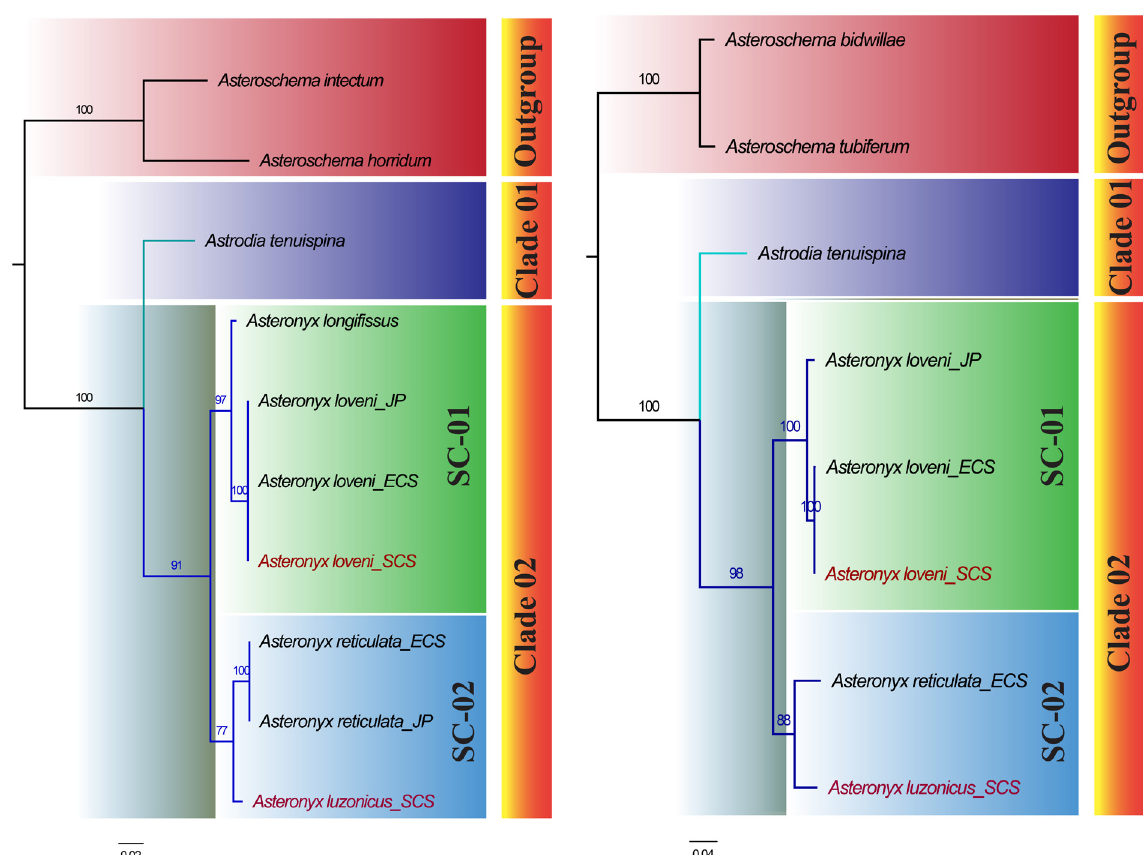
16S and COI sequences (bootstrap support values were generated with rapid bootstrapping algorithm for 1000 replicates). A . 16S ML. B . COI ML. Abbreviations: ECS = East China Sea; JP = Japan; SC = Sub-Clade; SCS = South China